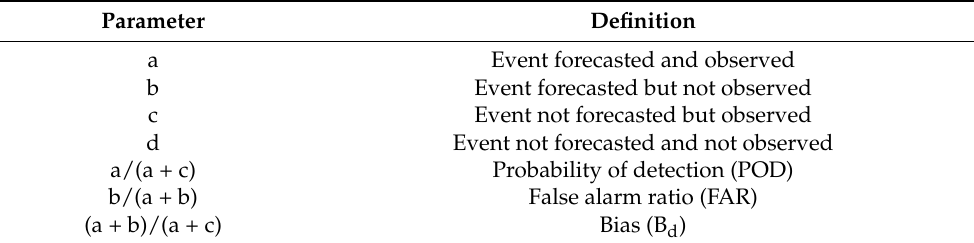
Table 1. Contingency table verification